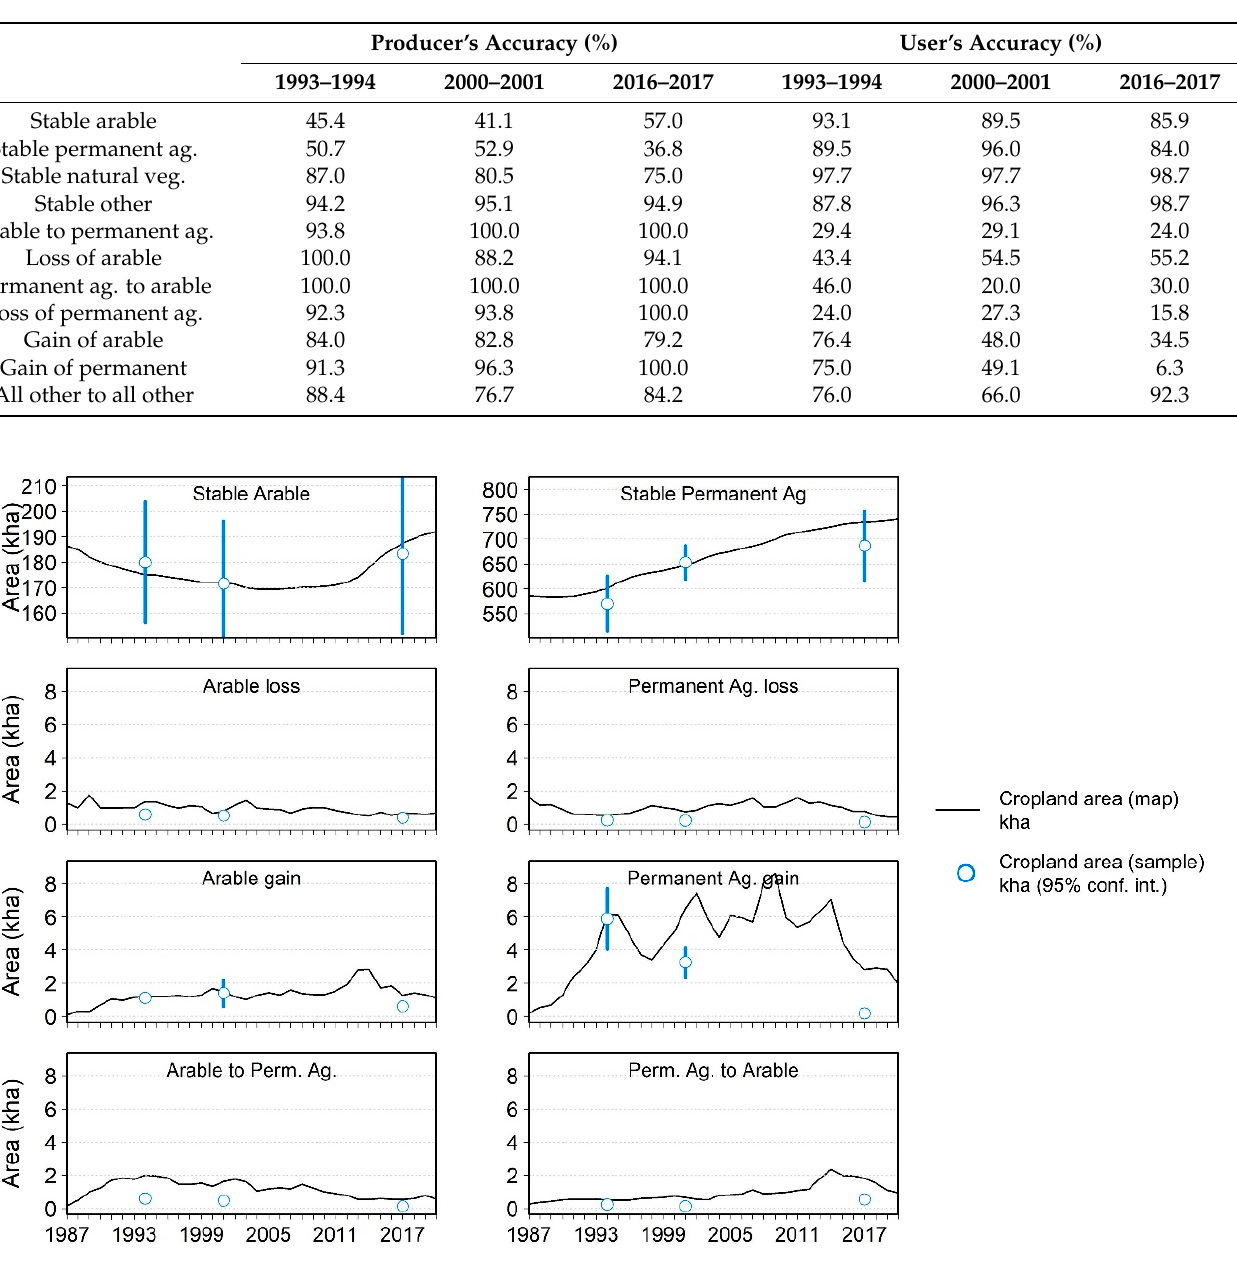
Table 5. Producer’s and user’s accuracies for stable and change strata for the three time periods assessed.